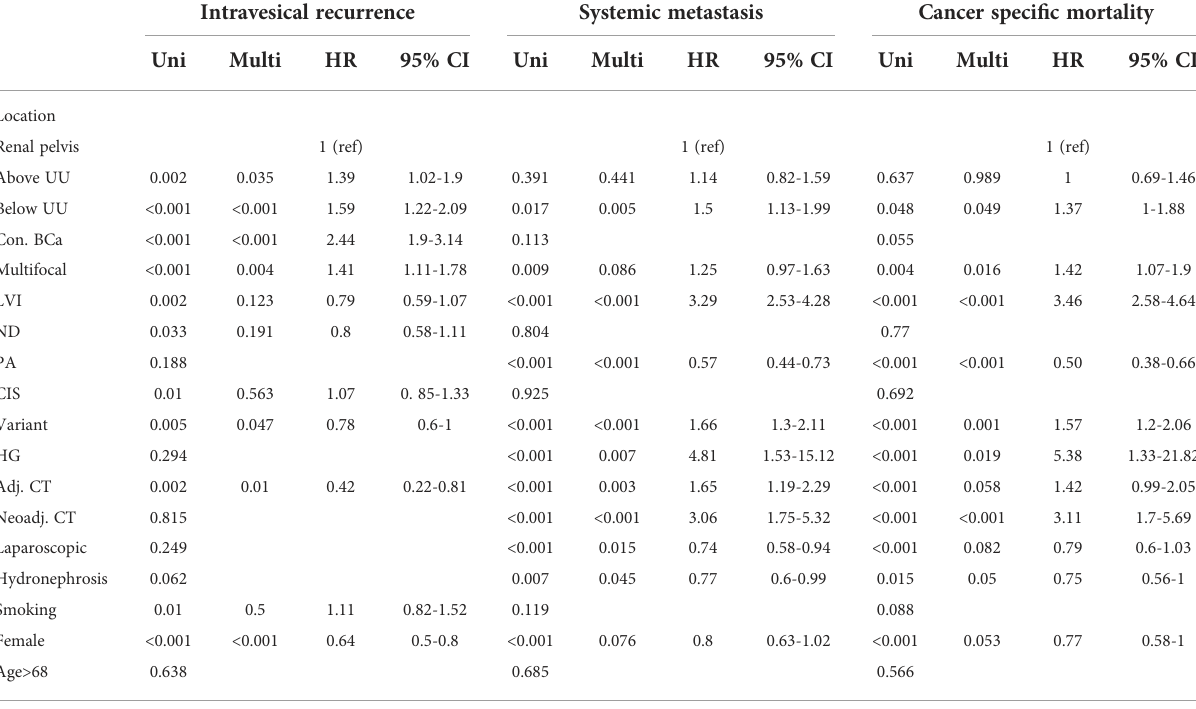
TABLE 2 Multivariate Cox regression analysis for oncological outcome.